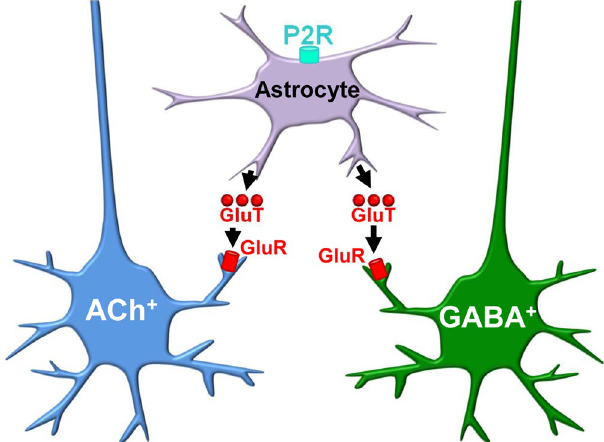
Figure 4. Hypothetical model of the cellular mechanism within basal forebrain (BF) which accounts for the wakefulness-promoting role of purinergic P2 receptors. Activation of purinergic P2 receptors (P2Rs) induces glutamate (GluT) release from astrocytes, leading to activation of extracellular NMDA and/or AMPA receptors on basal forebrain (BF) cortically-projecting, wakefulness-promoting cholinergic (ACh + ) and GABAergic (GABA + )